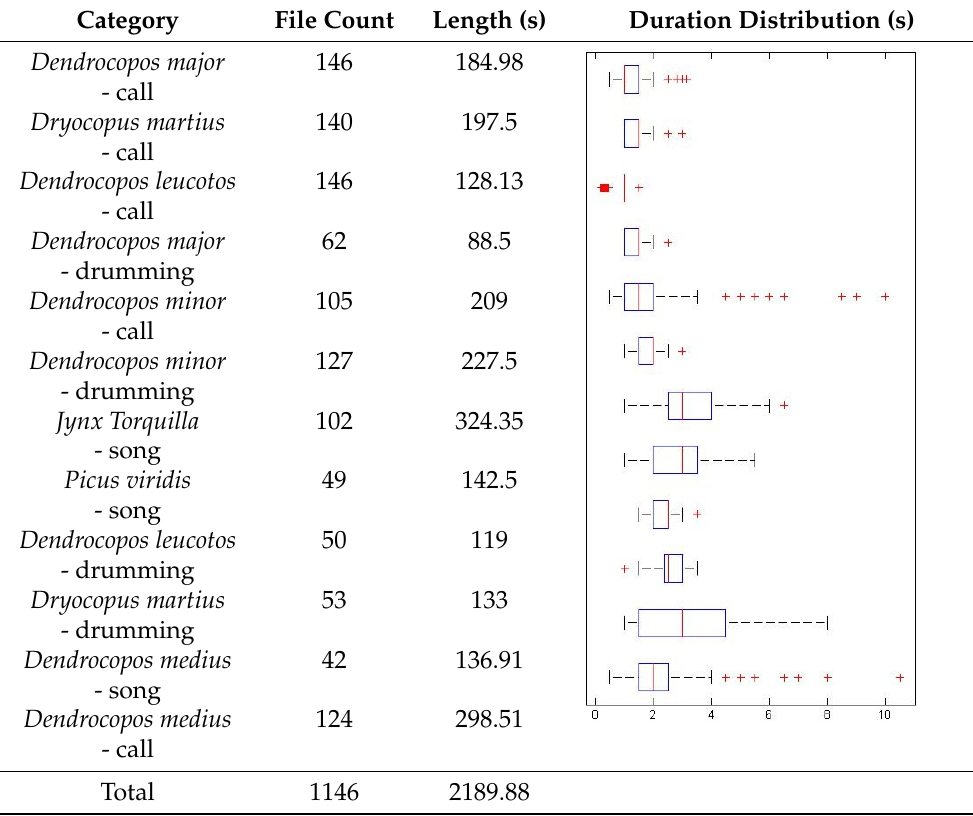
Table 5. Birds corpus composition